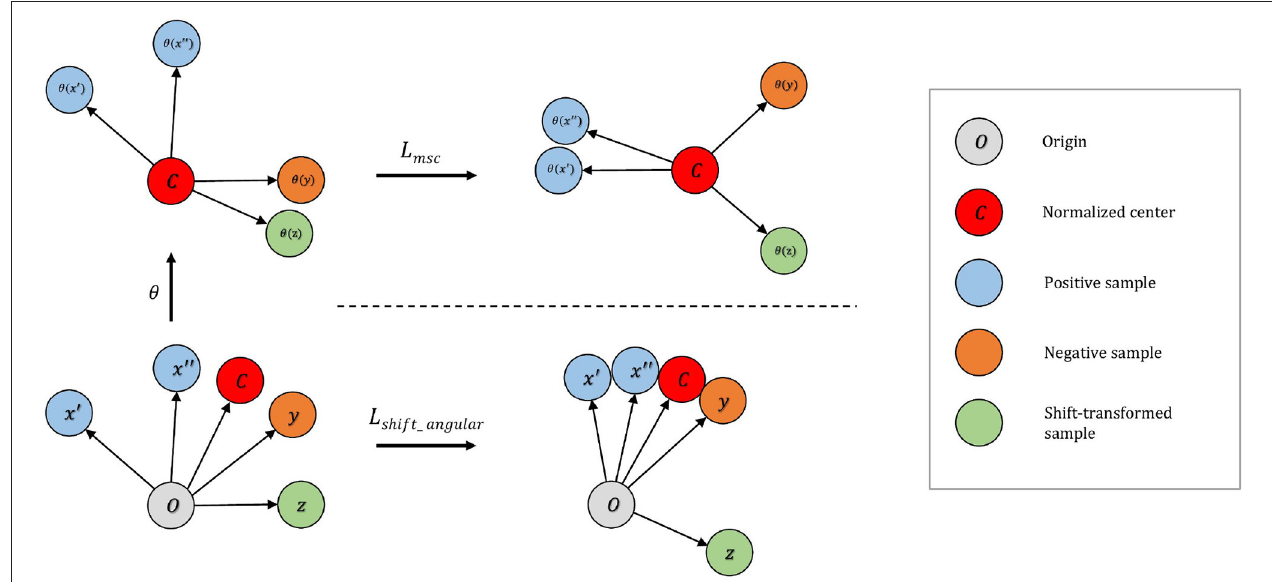
FIGURE 2 | Top: On the mean-shifted representation space, L msc maximizes the angle between negative pairs. Shift-transformed samples are treated as additional instances in this step. Bottom: On the angular representation space L shift_angular increases separability of anomaly by (i) increasing the angle between the embedding of normalized center and the shift-transformed samples; (ii) decreasing the angle between embedding of normalized center and normalized